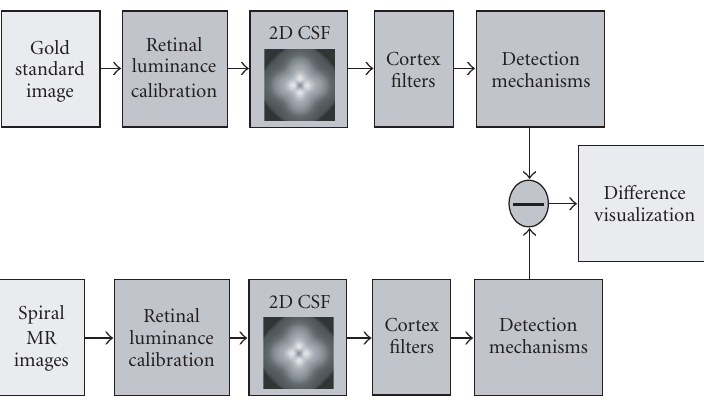
Figure 1: Perceptual di ff erence model (PDM). The output is a map showing the likelihood of a perceptual di ff erence between the two input images. The gold standard image is Shepp and Logan phantom reconstructed with ideal Cartesian k -space data. Subsequent test images are reconstructed from di ff erent spiral acquisition parameters and reconstruction methods at di ff erent noise levels. CSF refers to the contrast sensitivity function, which describes how sensitive human eyes are to various frequencies of visual